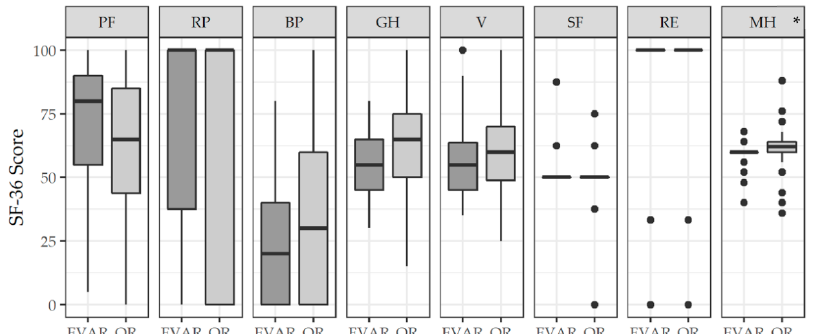
Figure 2. Health-related quality of life in patients after endovascular (EVAR) and open repair (OR) of an abdominal aortic aneurysm was assessed by means of the SF-36 questionnaire. Data are given as median and IQR (25% and 75% percentile). Dots represent suspected outliers ( ≥ 1.5 IQR). Mood’s median test. * p < 0.05 vs. EVAR. IQR: interquartile range; PF: physical functioning; RP: role physical; BP: bodily pain; GH: general health; V: vitality; SF: social functioning; RE: role emotional; MH: men- tal health.